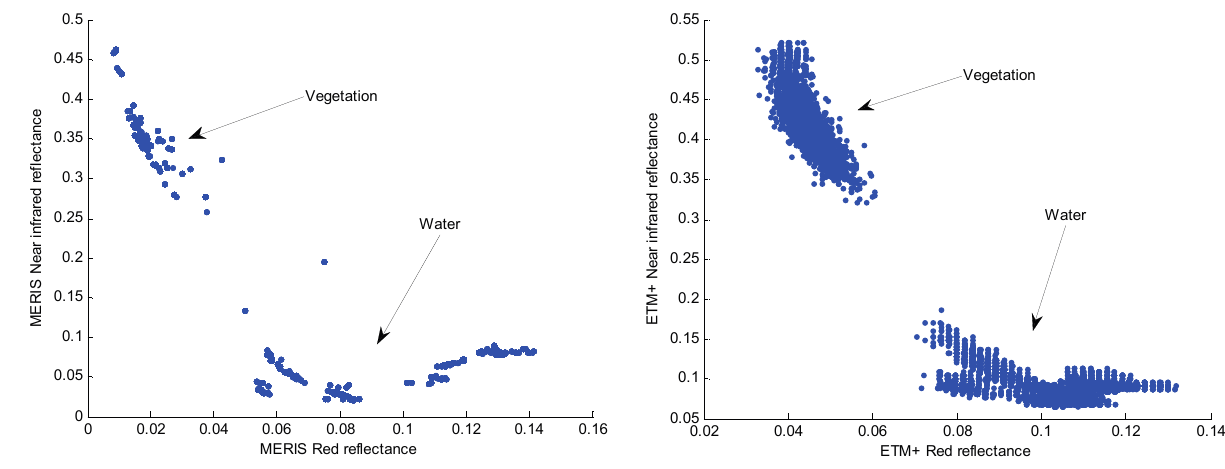
Figure 3. Scatter plots of the reflectance values at red and near infrared spectral bands to showing separability of vegetation and water classes from MERIS ( left ) and ETM+ ( right ).